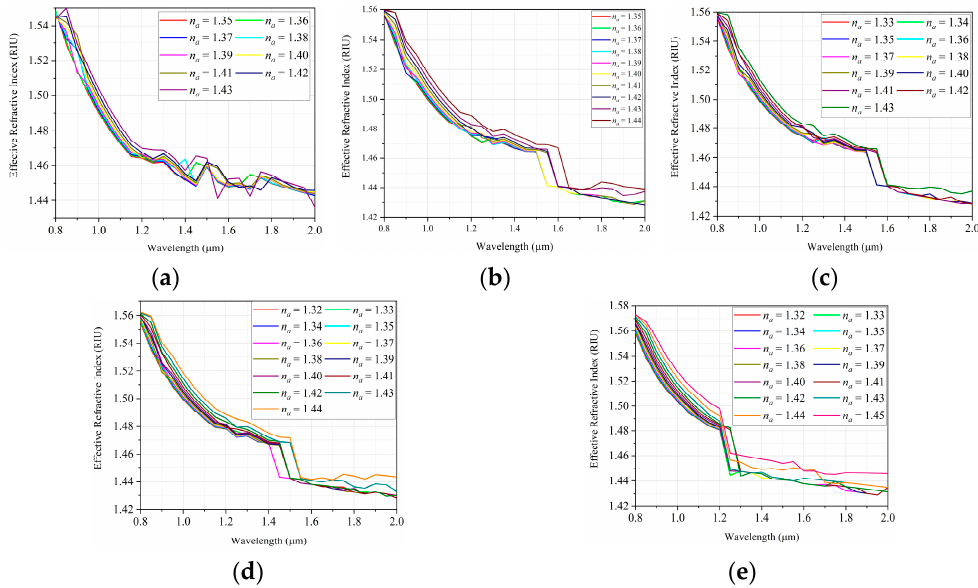
Figure 9. Relationship between effective RI and wavelength for the various detection ranges: ( a ) Defect without doping; ( b ) Doping with GeO 2 ( 4.1% ) ; ( c ) Doping with GeO 2 ( 6.3% ) ; ( d ) Doping with GeO 2 ( 13.5% ) ; ( e ) Doping with GeO 2 ( 19.3% ) .